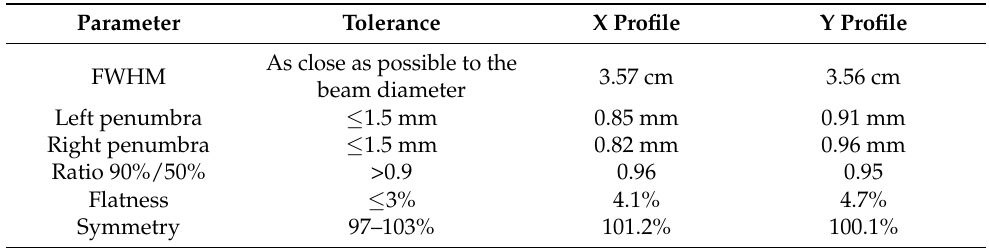
Table 3. Beam quality parameter tolerances and obtained results of the final lateral dose profiles. The calculation of quality parameters is defined in detail in [34,35].